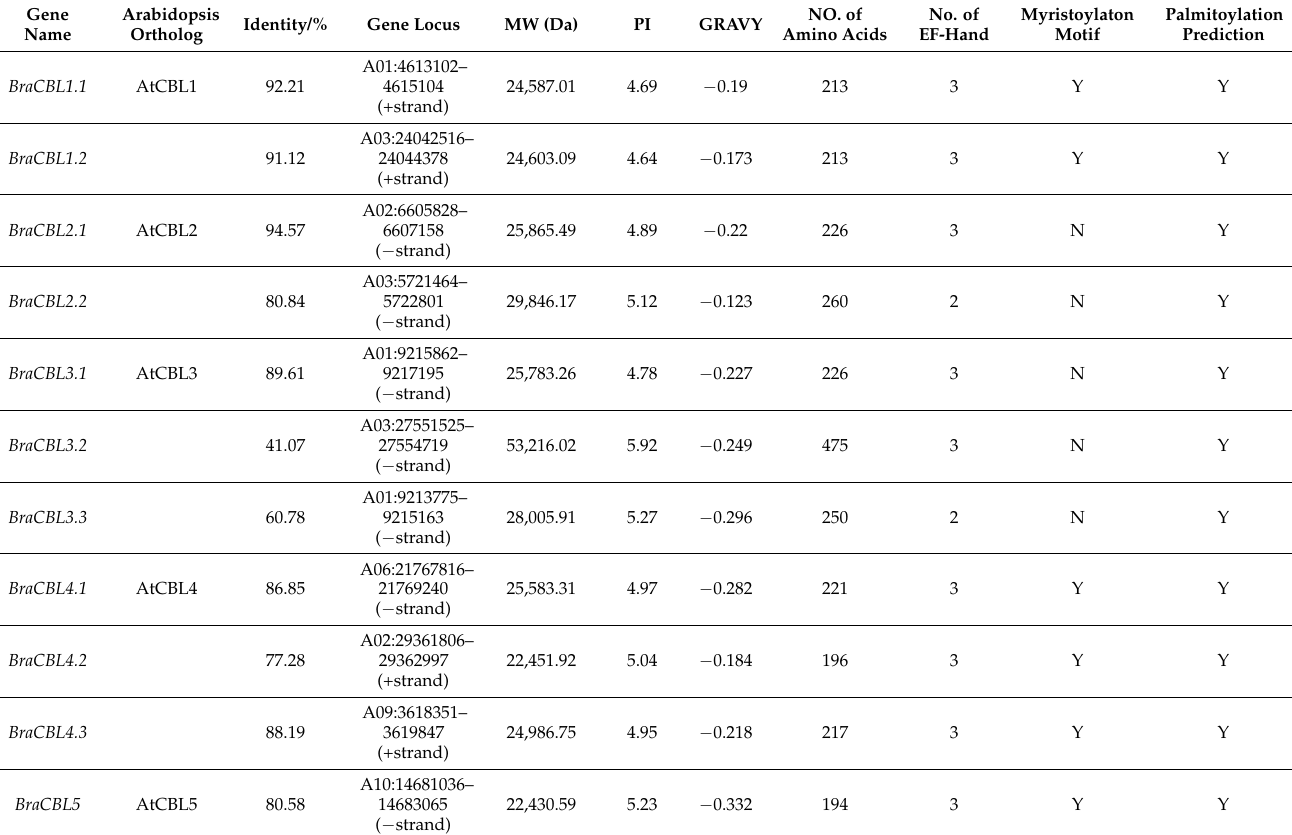
Table 1. Chinese Cabbage CBL genes identified and their